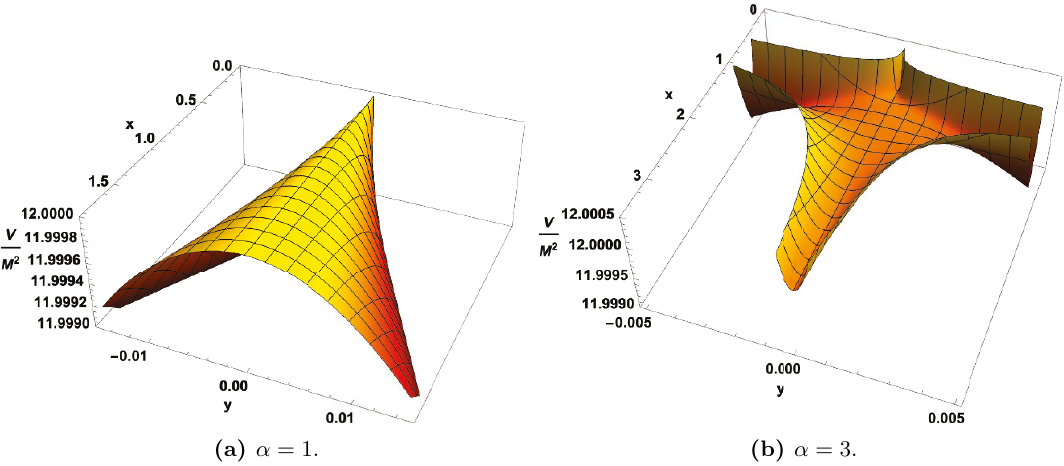
Figure 2. The effective scalar potential V ( x, y ) without quartic stabilization terms in the imaginary direction ( β = 0), for the cases α = 1 (left panel) and α = 3 (right